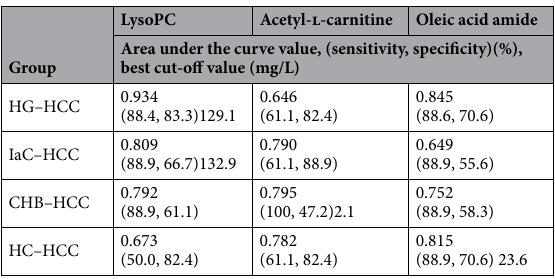
Table 4. The AUC value, sensitivity and specificity of the best cutoff and the cutoff value of the largest AUC, three metabolites.